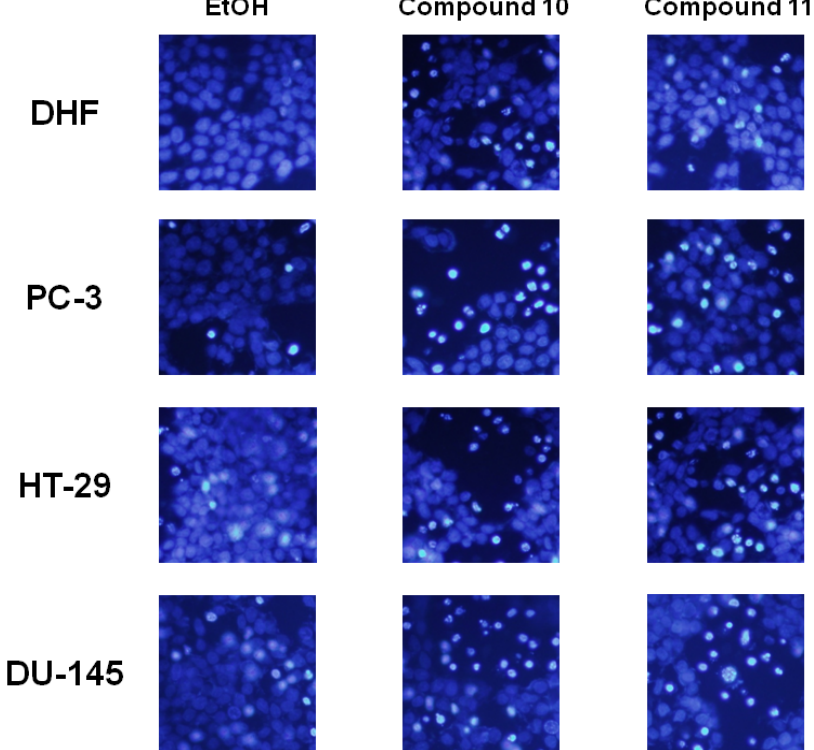
Figure 4. Effect of ent -cyclozonarone and compound 11 on chromatin condensation and fragmentation. PC-3, HT-29, DU-145 and DHF cells treated with either compound were stained with Ho33342 (400×). Representative photographs of nuclear morphologic changes observed by fluorescent microscopy of the treated